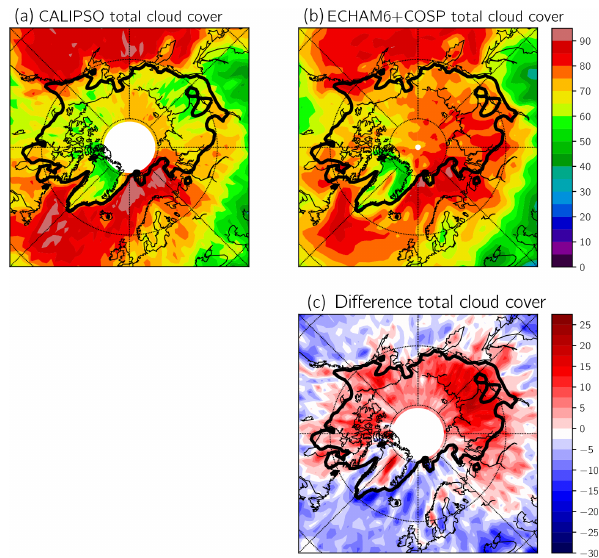
Figure 2. (a, b) Multiyear (2007–2011) mean total cloud cover as observed by CALIPSO and ECHAM6 + COSP. (c) Difference be- tween the model and CALIPSO total cloud cover. Black line indi- cates regions with sea ice cover greater than 50% or snow cover greater than